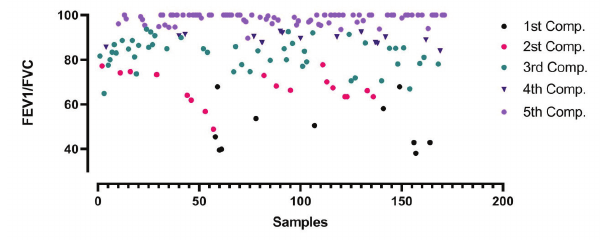
Figure 6. Distribution of dependent variable according to five components